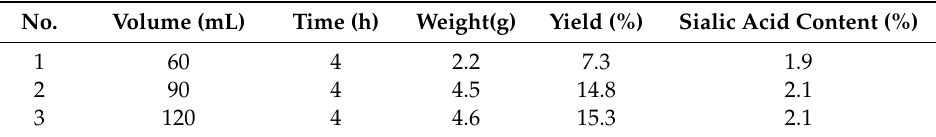
Table 1. E ff ect of the volume of entrainer on ganglioside extraction by